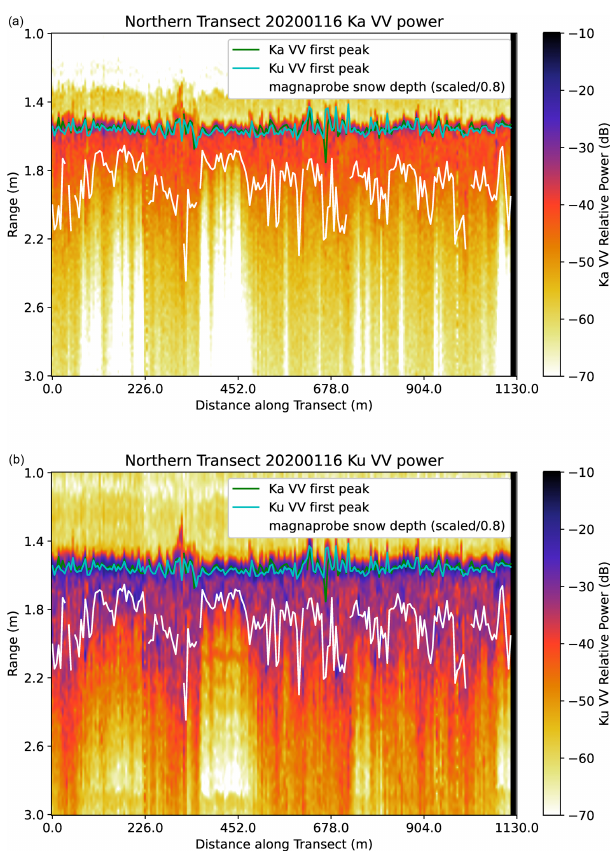
Figure 9. Ka (a) and Ku (b) VV power along the northern transect on 16 January 2020. The data have been corrected for ice motion to allow intercomparison between KuKa and Magnaprobe data gath- ered from 10:46 to 12:17 and 10:36 to 12:44UTC, respectively. The transect has been divided into 5m sections; for each section the av- eraged KuKa echoes and Magnaprobe snow depth data are shown. The green and cyan lines indicate the ranges of the first peaks de- tected in the Ka and Ku echoes, respectively. The white line indi- cates the snow depth (from nearby Magnaprobe data) plotted with depths measured from the Ka VV first peak for each echo and di- vided by 0.8 for comparison with the radar data, to account for the slower EM radiation propagation of the radar in snow relative to free